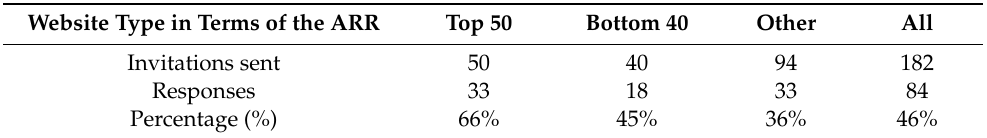
Table 6. Questionnaire form response